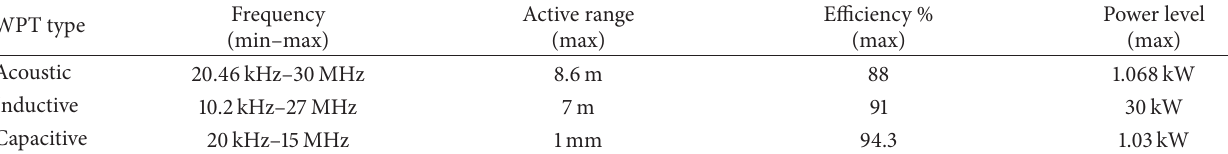
Table 3: Comparison of